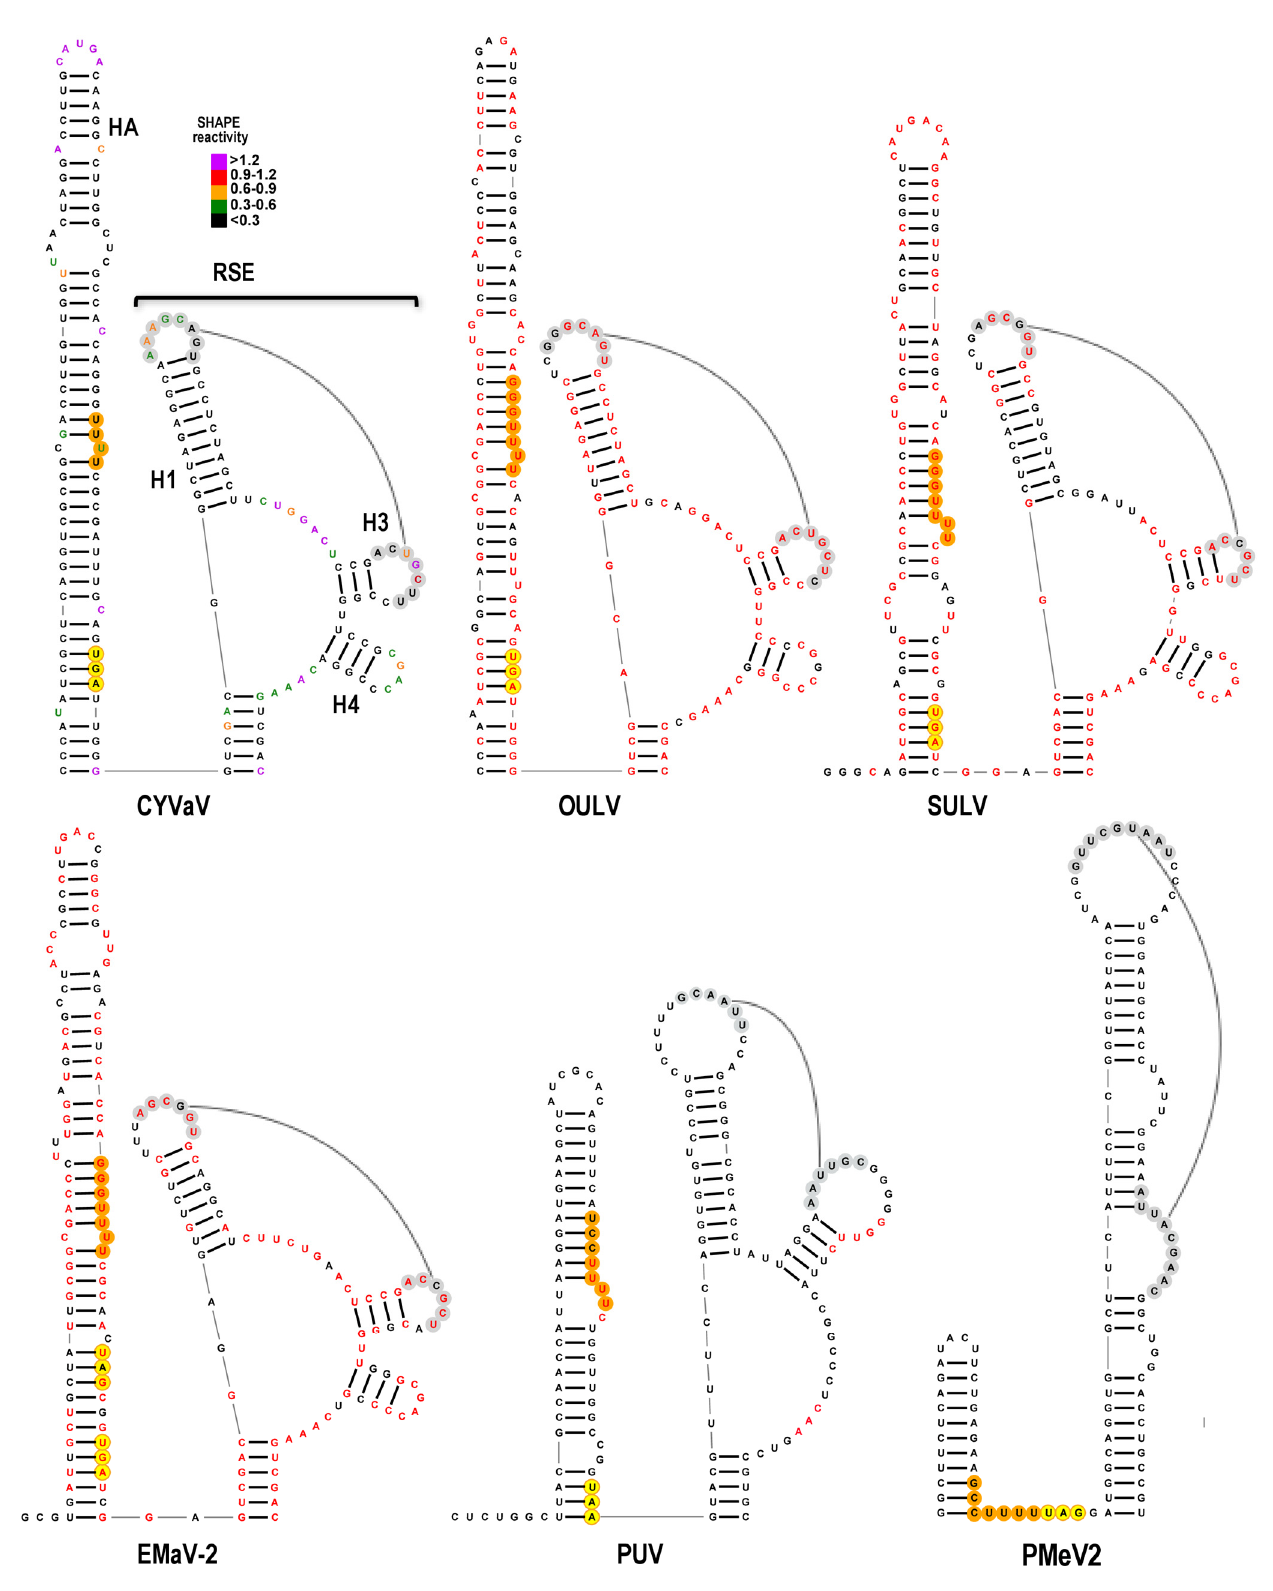
Figure 7. Alternative conformation of structures at the -1PRF site in ulaRNAs. See legend to Figure 6. Since most of the ulaRNA recoding sites are markedly different from those of um- braviruses, we were interested in determining the efficiency of the frame-shifting event